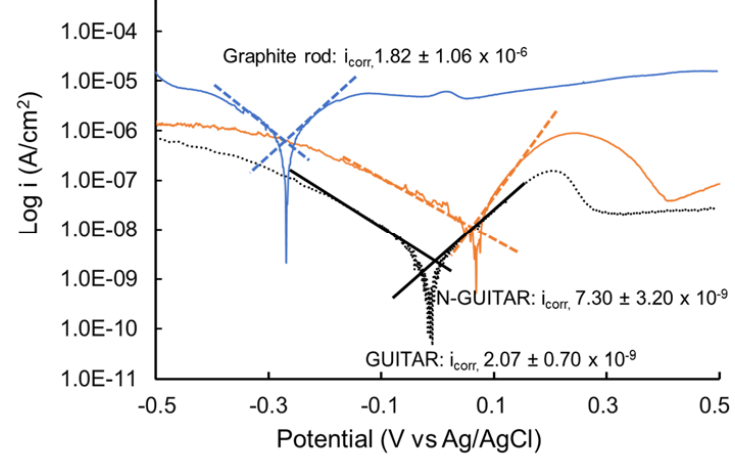
Figure 7. Tafel Plots with extrapolated corrosion currents (i corr , A/cm 2 ) indicated for each. The